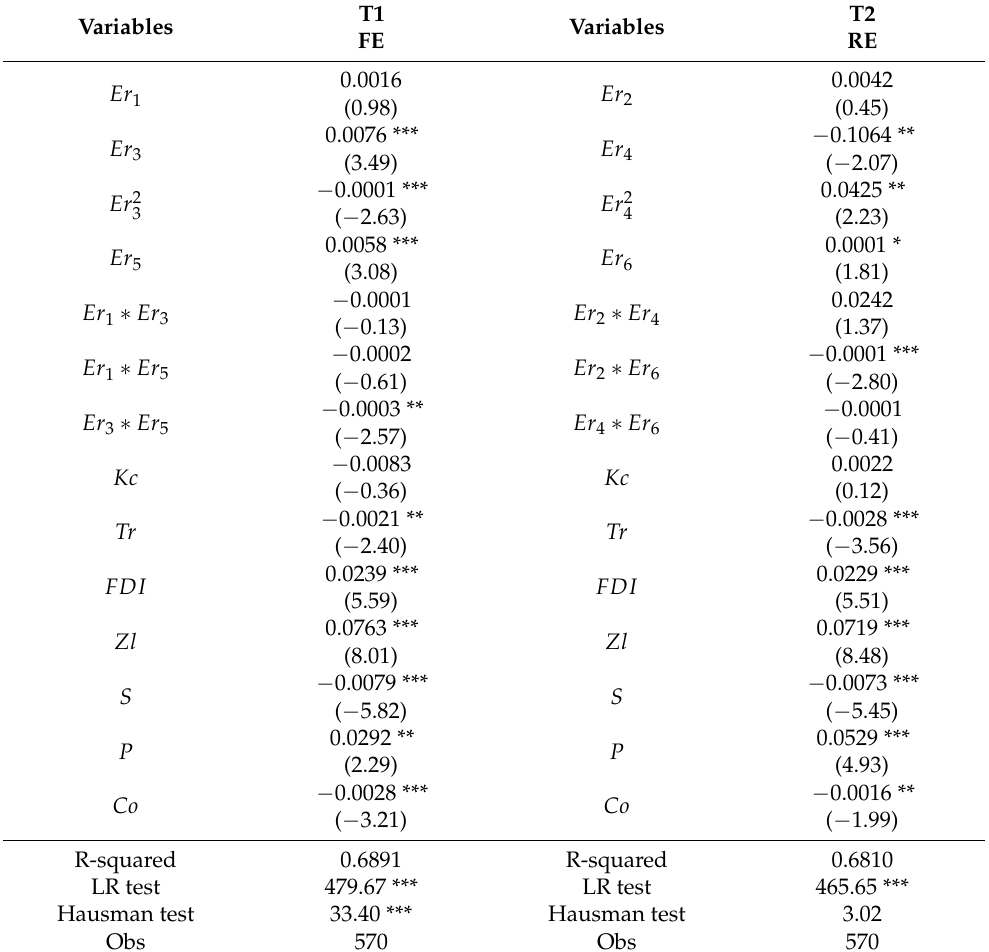
Table 7. Regressions of interaction effect of different environmental regulations: Nationwide. T1 Variables FE